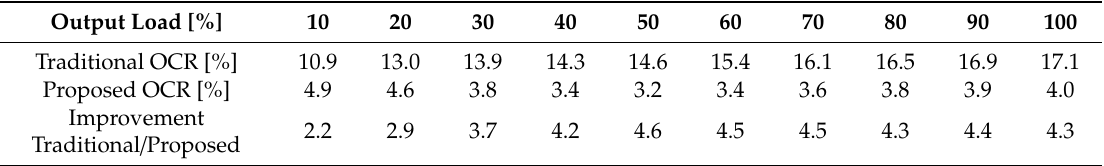
Table 5. Measurements of load percentage versus output current ripple percentage at input voltage of 220